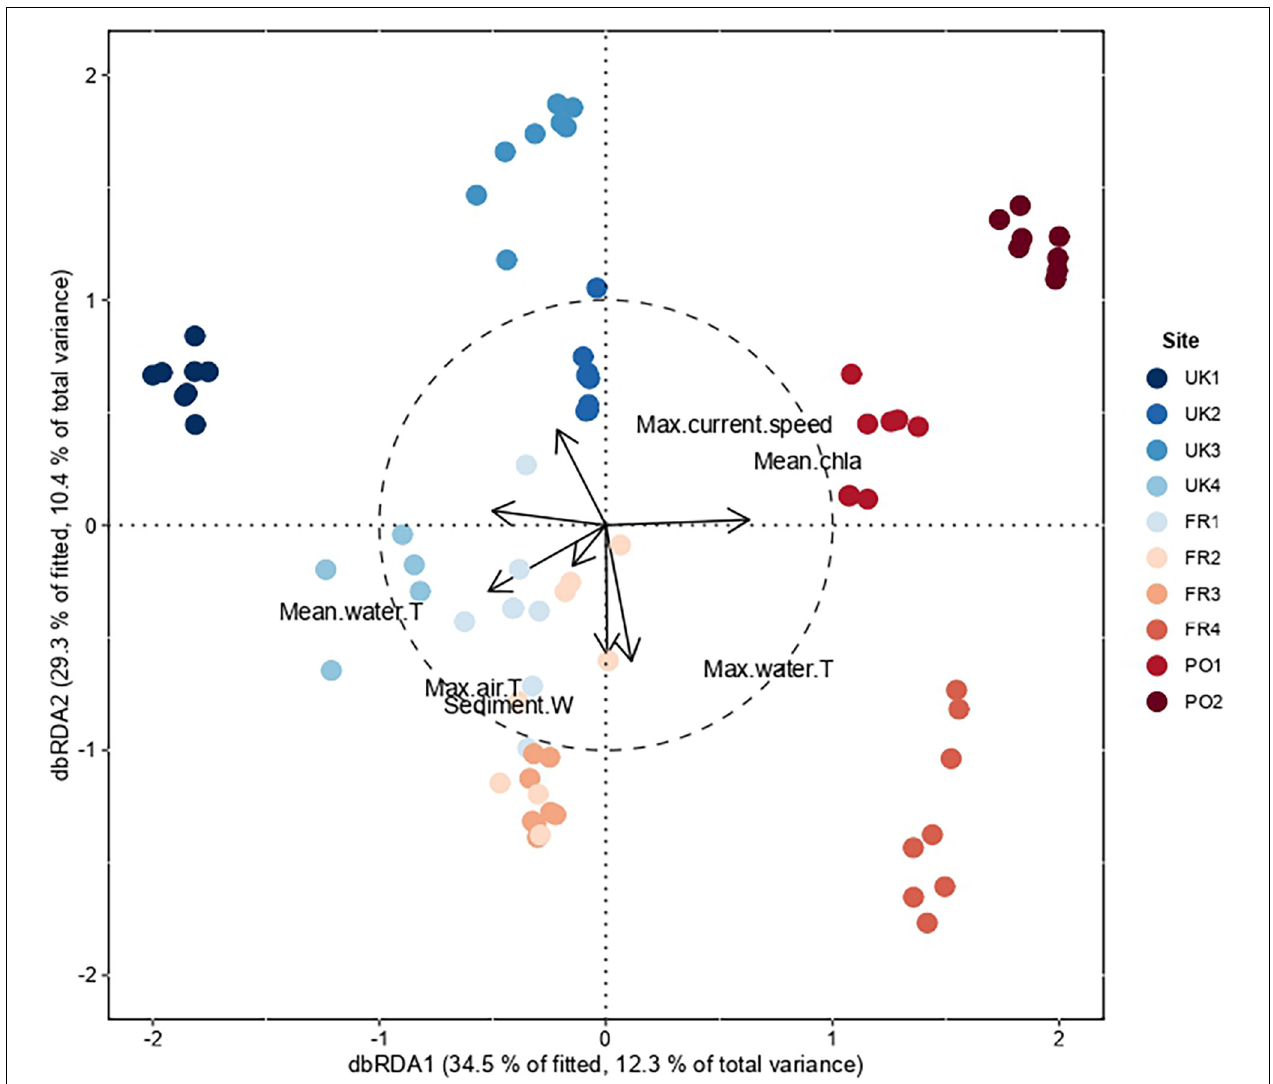
FIGURE 3 | Result of the distance-based redundancy analysis (dbRDA) using the Bray–Curtis dissimilarity matrix computed on the log-transformed abundance data and the seven selected environmental variables. Field data: “Water” and “Air (T ◦ C max)” = maximum air and water temperature, “Sediment” = amount of sediment in g.m − 2 , “Density SA” = density of S. alveolata (ind.m − 2 ). Data extracted from BioORACLE: “Chla” = average chlorophyll level (mg.m − 3 ), “Water (T ◦ C avg.)” and “Current (max)” = average maximum current velocity (m.s − 1). The first two axes capture 22.9% of the variation explained by these seven